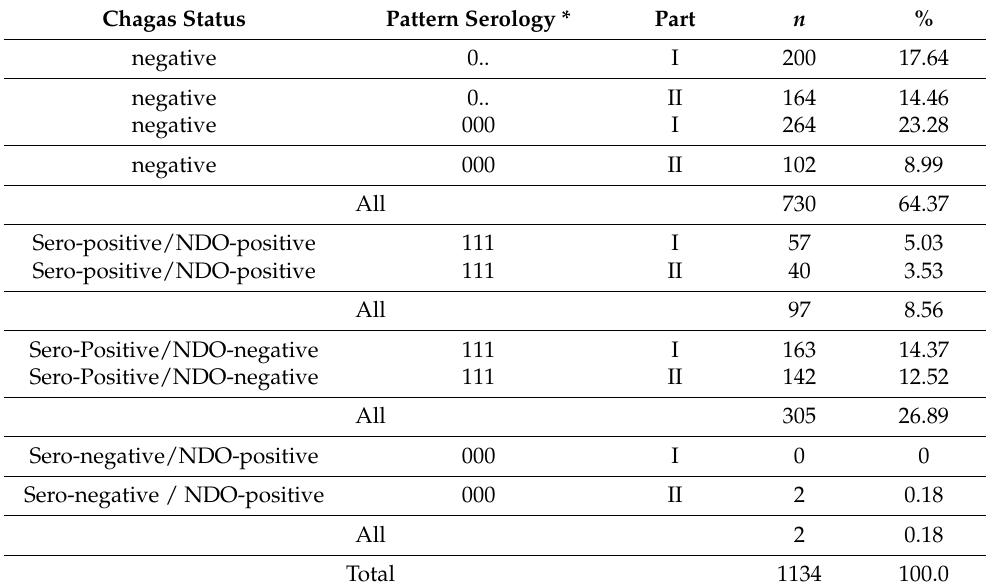
Table 1. Combined presentation of serological and PCR results of Chagas diagnostics in the entire study population ( n = 1134). Pattern Serology